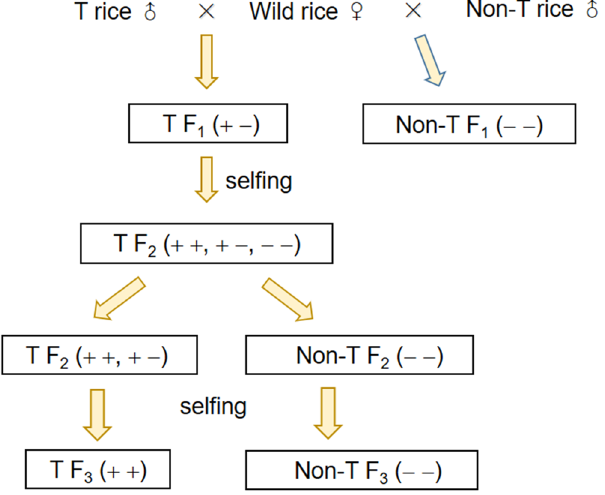
Figure 6. Schematic illustration of the pedigrees to produce F 1 -F 3 crop-wild hybrid lineages. T: transgenic; + + , + − , and − − : transgene homozygous, transgene heterozygous, and non-transgenic, respectively. F hybrid lineages were used to test differences in fitness; the F 3 hybrid lineages were used to test differences in seed germination after being buried in